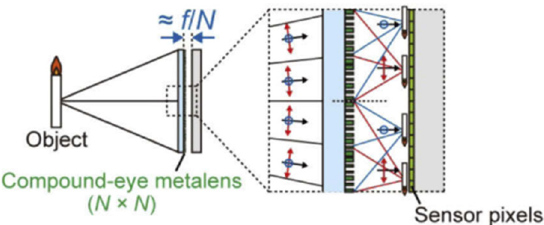
Figure 21 . The metalens layout. Reproduced with permission from [72] © The Optical Society.